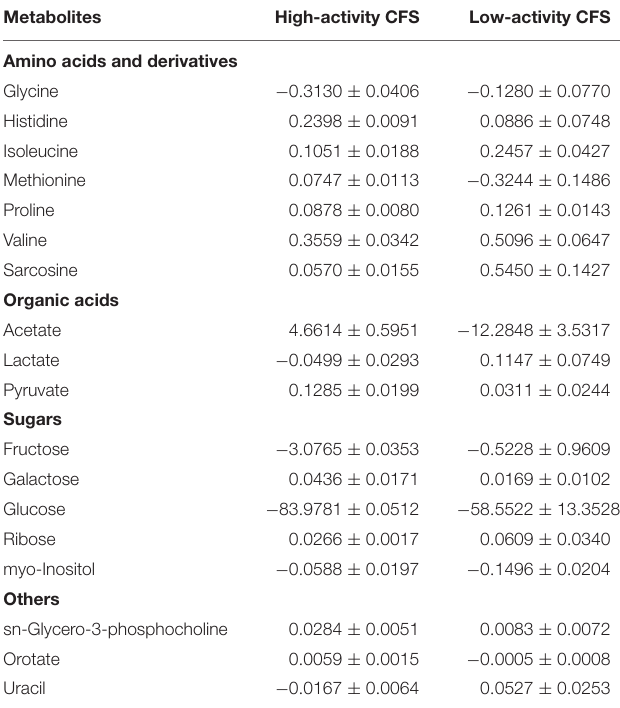
TABLE 3 | List of metabolites significantly different between Lactobacillus CFS belonging to high anti- Candida activity group and low anti- Candida activity group ( p < 0.05) and concentrations, calculated as differences with respect to MRS medium [median value ± MAD